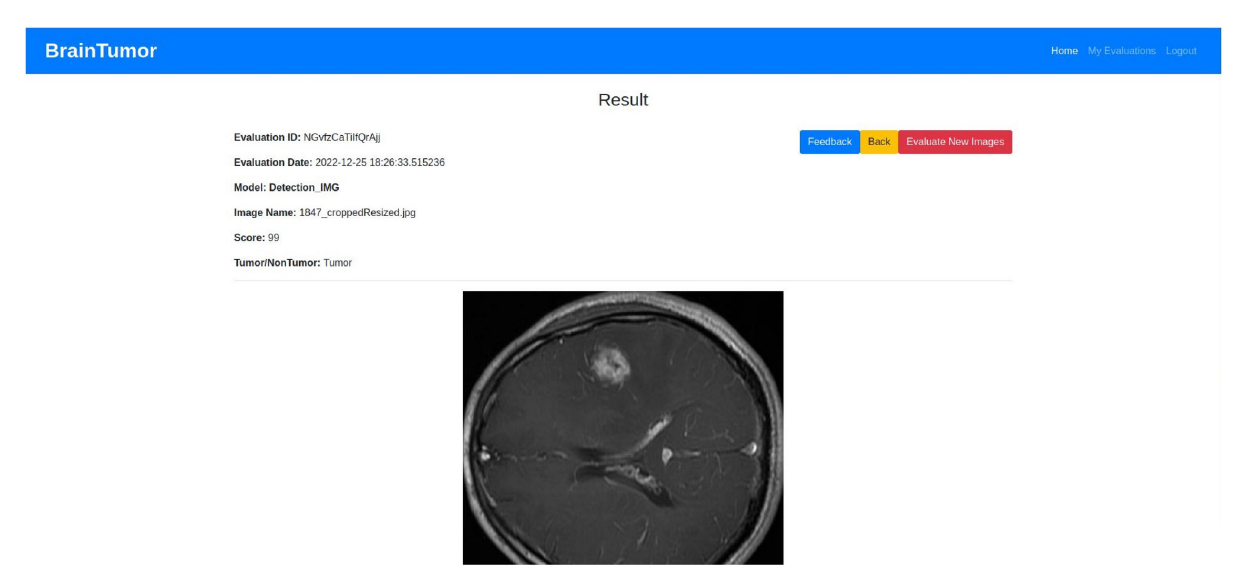
Fig 14. Tumor detection show result page.